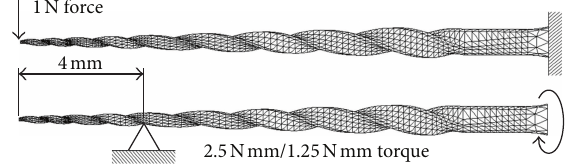
Figure 2: Finite Element model mesh with load and boundary conditions (example for a GTX